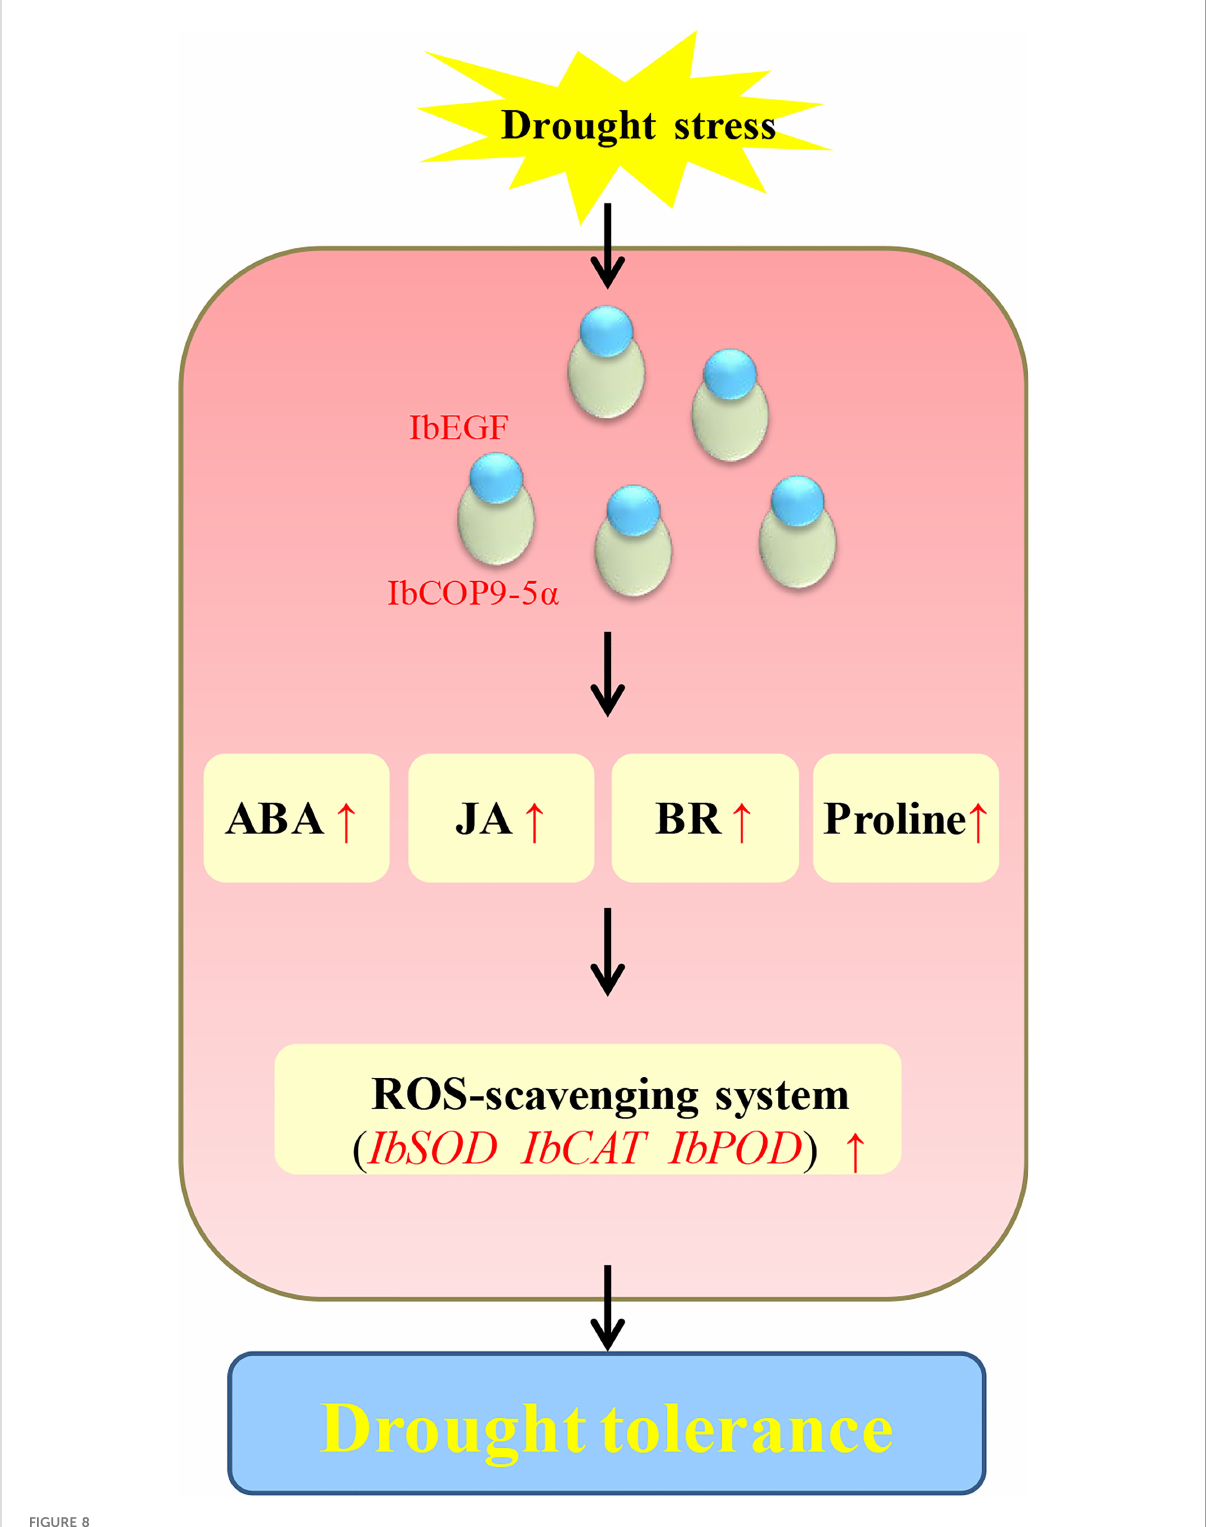
FIGURE 8 Proposed working model of IbEGF in the transgenic sweet potato plants to drought